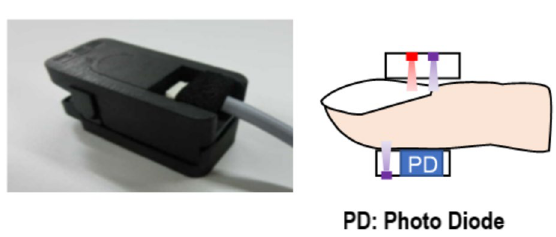
Figure 1. The image of the device. We set this device to a fingertip and measured LFCT. LFCT: lung to finger circulation time, PD: photo